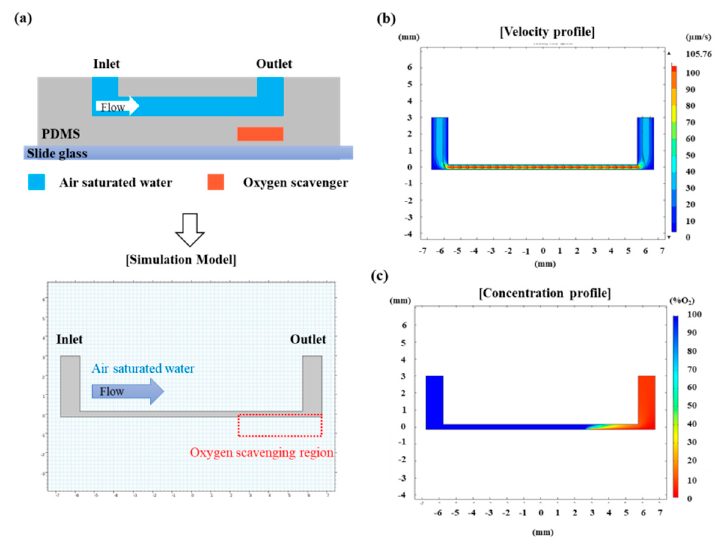
Figure 3. Numerical calculations of the oxygen concentration in the microfluidic device. ( a ) Modeling of 2D flow in the cell culture channel under oxygen diffusion; ( b ) flow velocity profile; and ( c ) oxygen concentration profile in the cell culture channel.